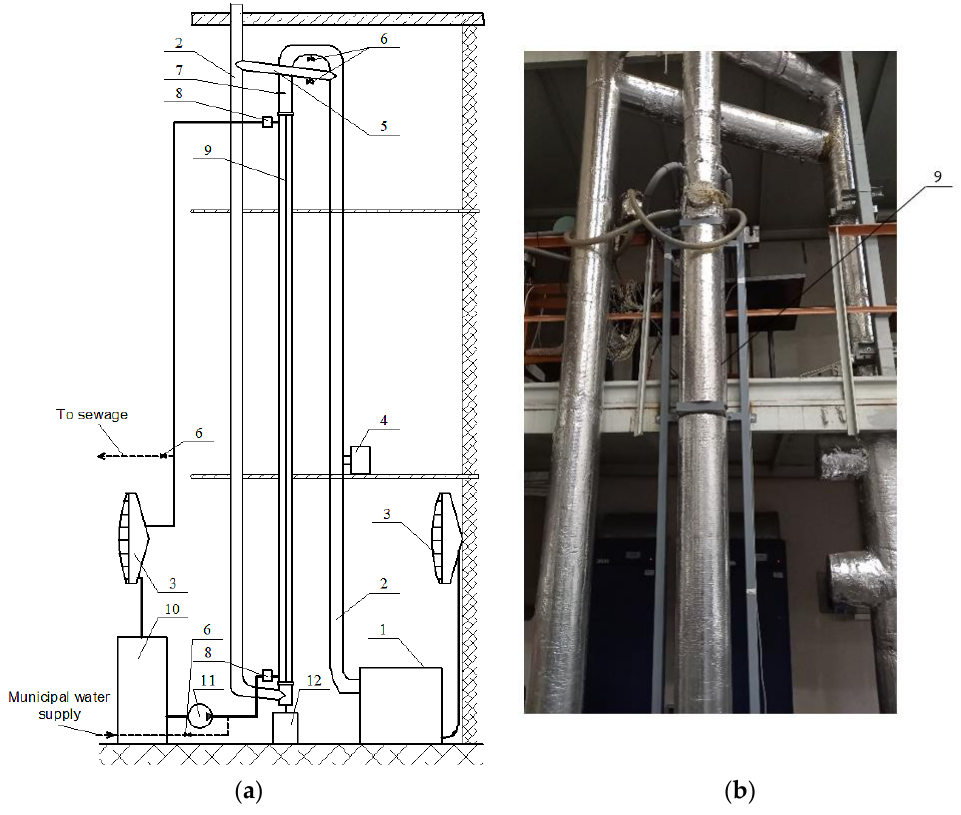
Figure 1. ( a ) The experimental setup: (1) boiler, (2) chimney, (3) air cooled heat exchanger, (4) flue gas exhauster, (5) bypass pipe, (6) valve, (7) inlet flue gas flow rate, humidity and temperature measurement place, (8) water mixer, (9) vertical calorimetric tube, (10) distilled water tank, (11) water pump, (12) vessel for condensate collection. ( b ) General view of experimental test section.